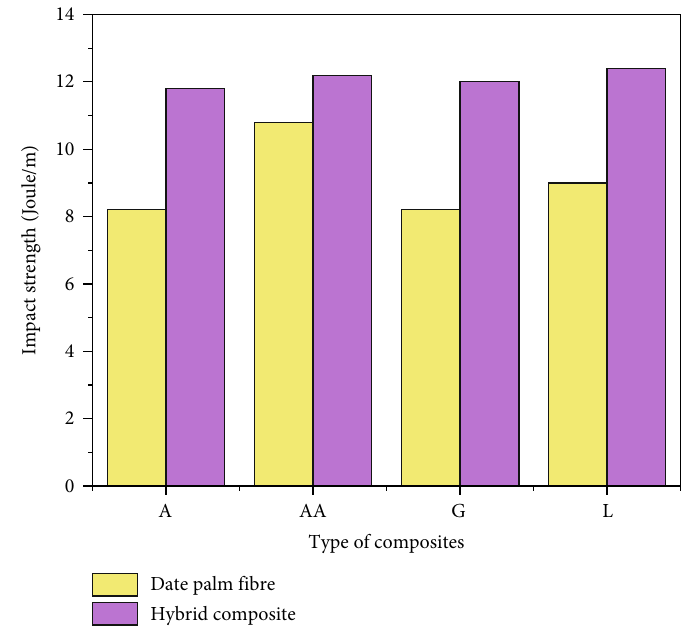
Figure 11: Impact strength of hybrid